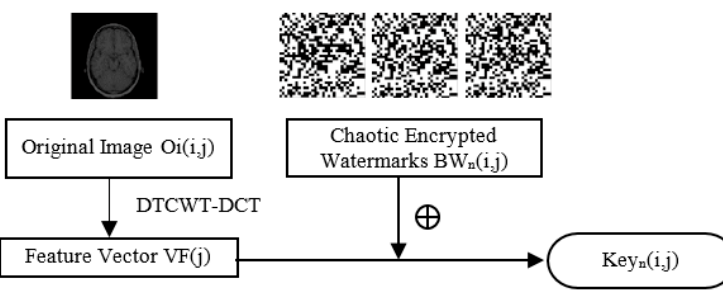
Figure 10. Watermarks embedding algorithm.